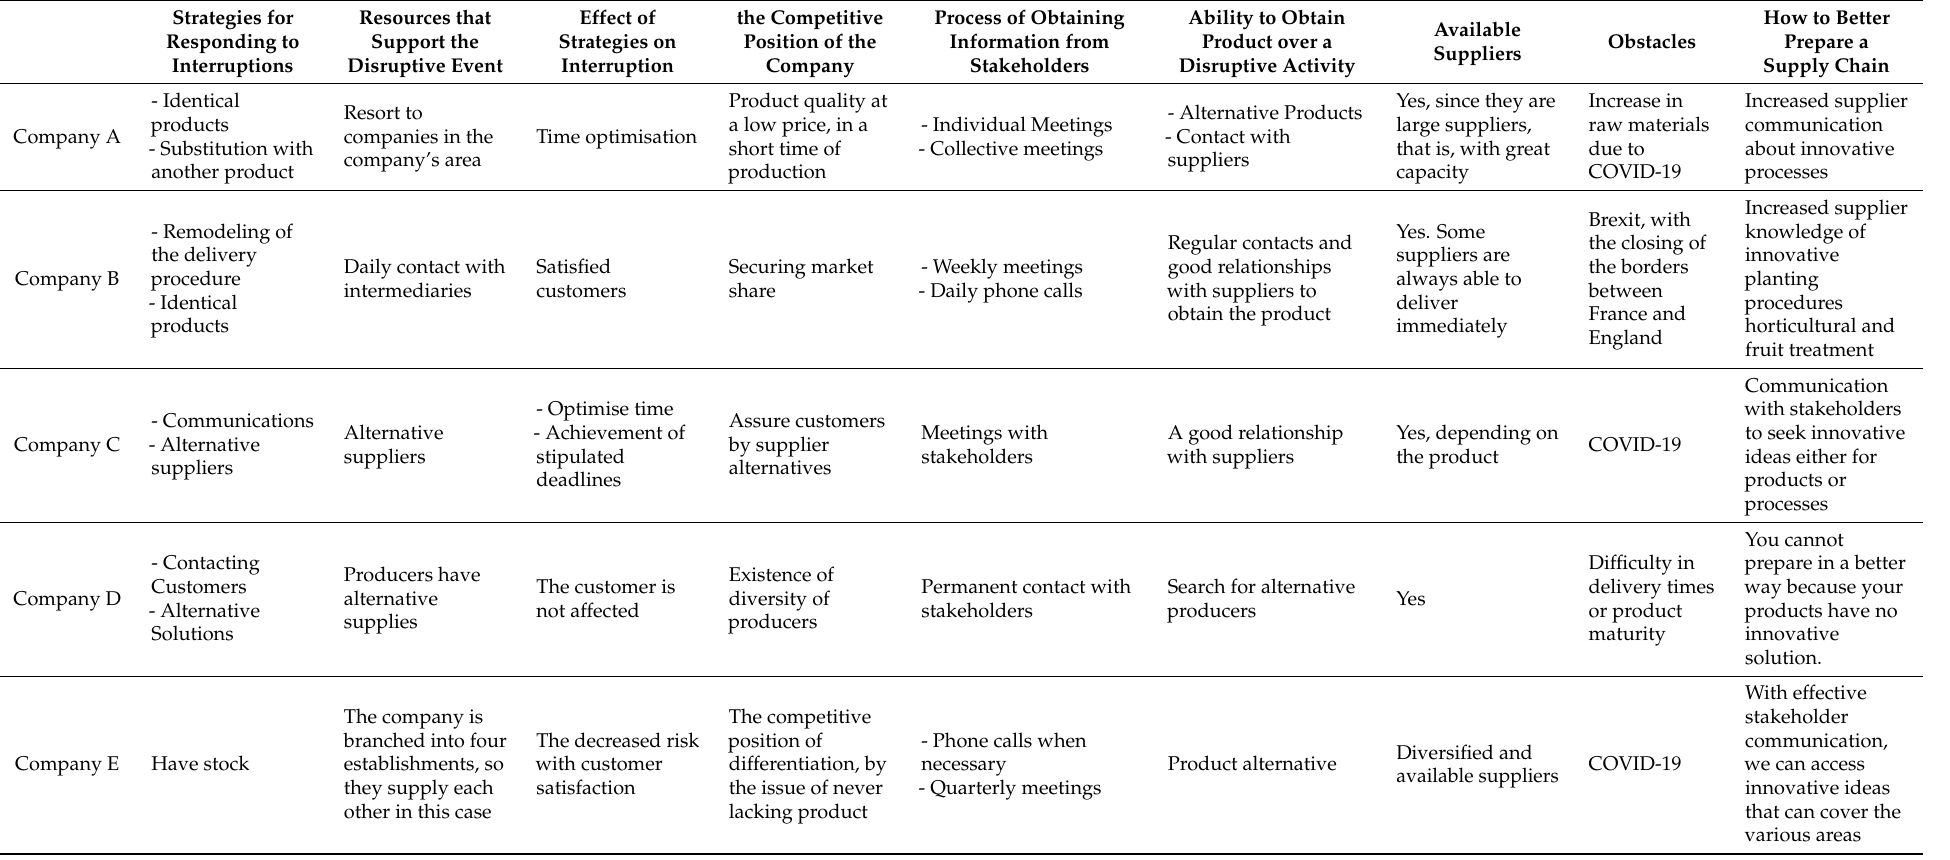
Table 5. Summary of results of resilience in the supply